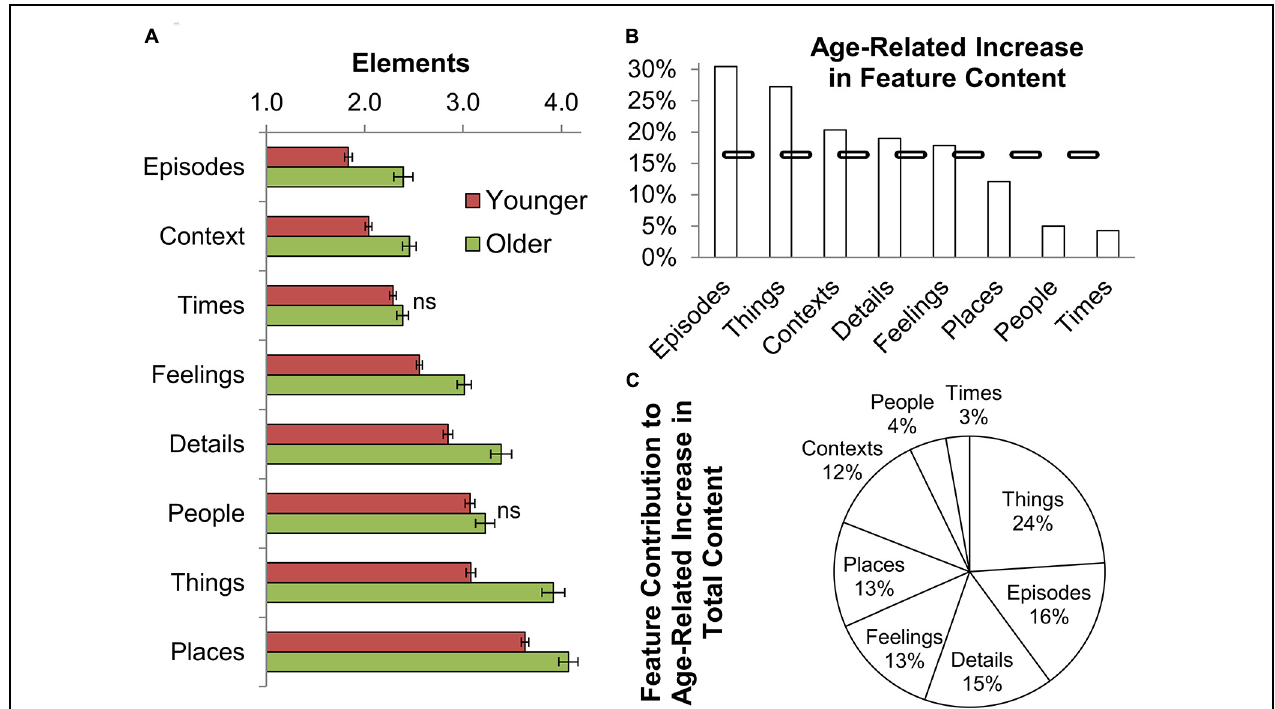
FIGURE 4 | Selective feature contribution to the age-related increase in total content. (A) Subjects of all ages reported more AM elements related to Places , Things , and People , and fewer related to Episodes, Contexts , and Times (Younger subjects: 18–45 years old; older subjects: 46–78 years old). Older adults reported more elements within all features (the age-related increase is statistically significant unless marked as ns ;